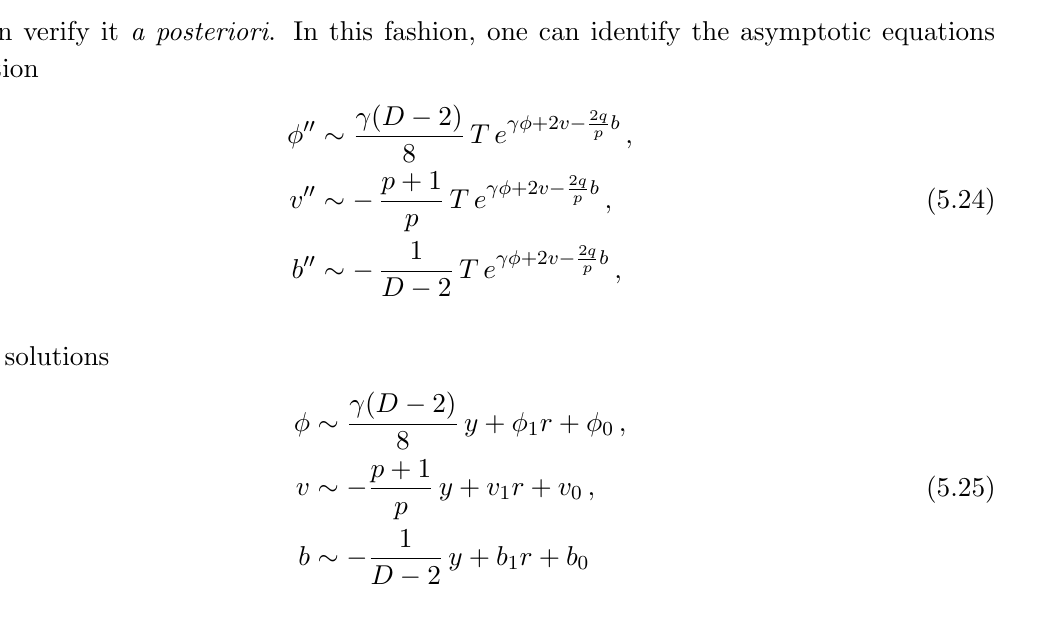
(cid:0) 1 (only values outside of the event horizon are e , whose length in units of log (cid:26) AdS 2 (cid:2) S 2